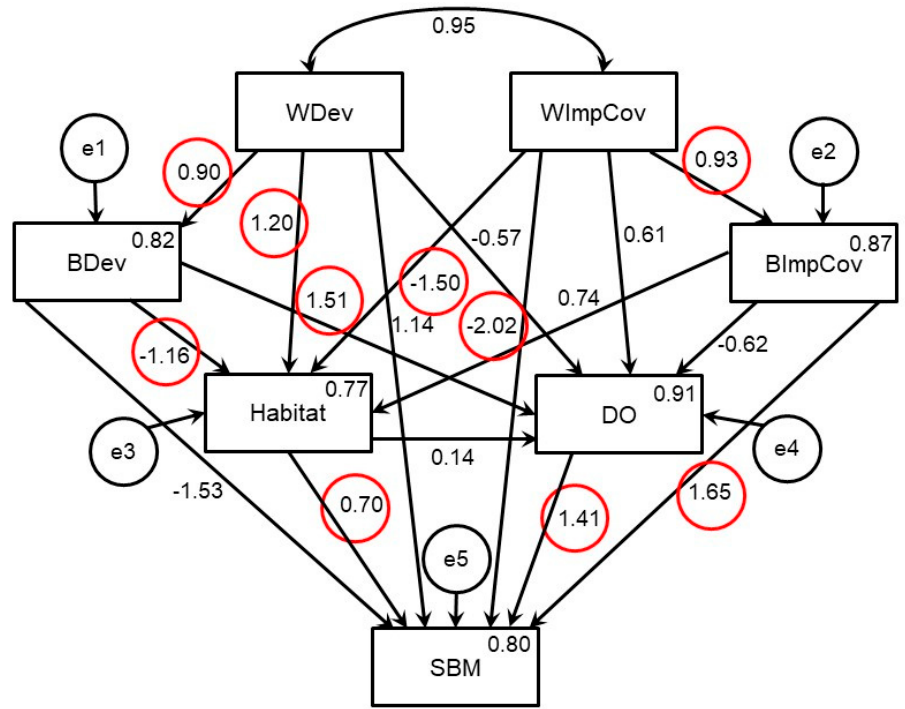
Figure 4. Final SPSS ® AMOS 20 path analysis model of the 10 stations in the Charles River watershed including watershed developed (WDev), buffer developed (BDev), watershed impervious cover (WImpCov), buffer impervious cover (BImpCov), habitat, dissolved oxygen (DO), Streamside Biosur- vey for Macroinvertebrates (SBM), and errors (e1–e5). Standardized direct effects are shown in the middle along each arrow. Squared multiple correlation values are shown at the top right corner of each variable. Red circles indicate statistically significant